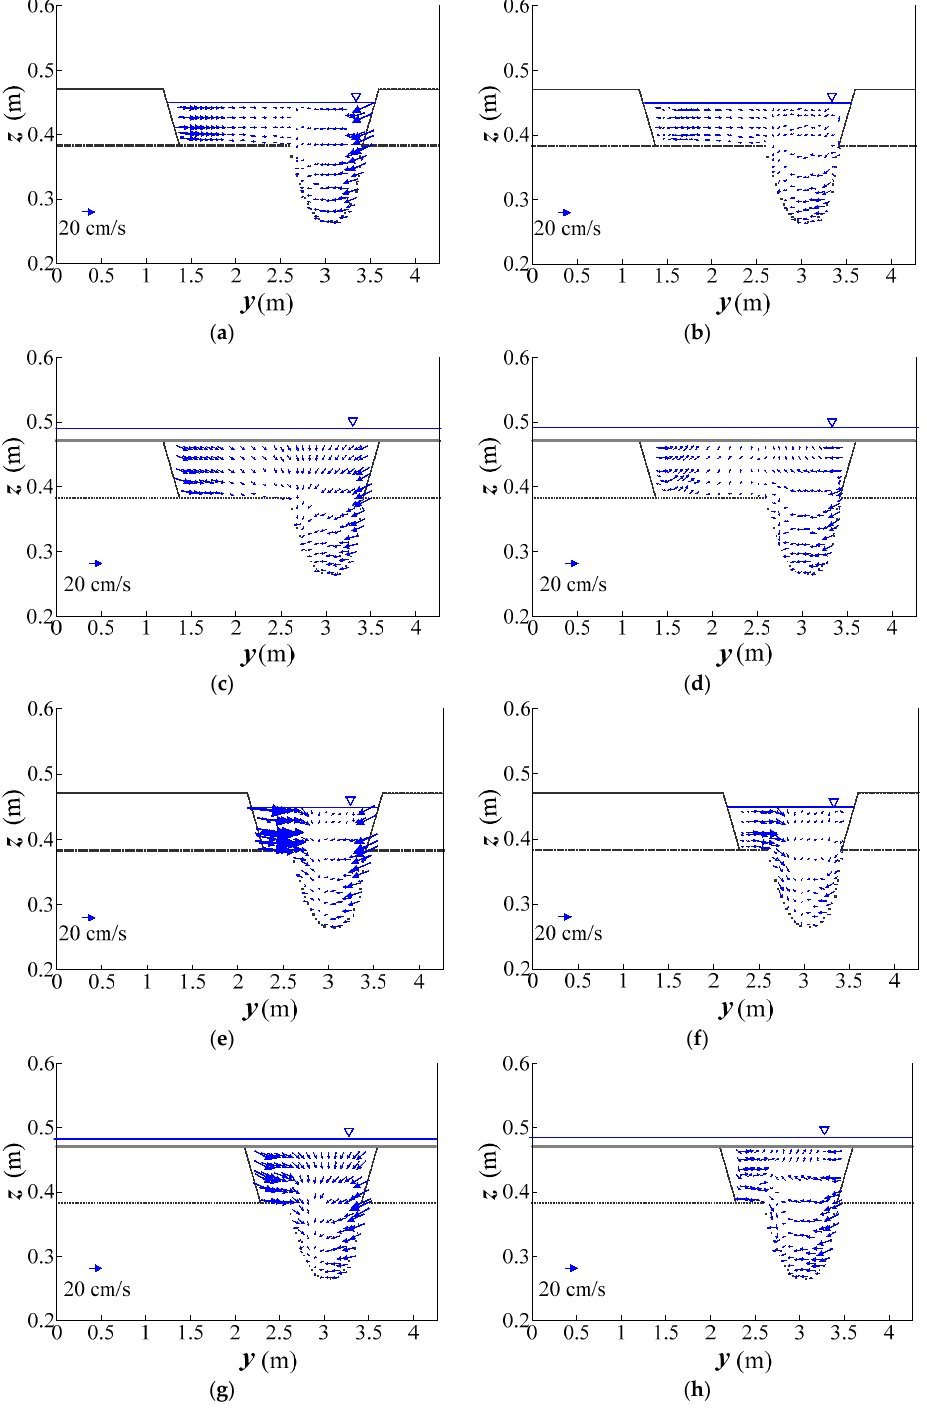
Figure 5. Cross-sectional velocity vectors measured at C.S. 1 and C.S. 2 for each run. ( a ) v-w plot at C.S. 1 (Run 1, F), ( b ) v-w plot at C.S. 2 (Run 1, F) ,( c ) v-w plot at C.S. 1 (Run 3, OT), ( d ) v-w plot at C.S. 2 (Run 3, OT), ( e ) v-w plot at C.S. 1 (Run 13, F), ( f ) v-w plot at C.S. 2 (Run 13, F), ( g ) v-w plot at C.S. 1 (Run 15, OT), ( h ) v-w plot at C.S. 2 (Run 15,